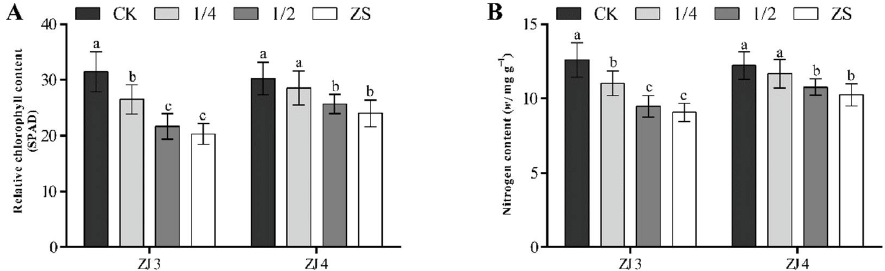
Figure 5. Effects of S. indica on relative chlorophyll content ( A ) and nitrogen content ( B ) in leaves of ‘Zhongjiao No.3’ (ZJ3) and ‘Zhongjiao No.4’ (ZJ4) banana seedlings. CK: S. indica non-colonized controls; S+: S. indica colonized banana seedlings. Different letters above the bars indicate a significant difference at 0.05 level.